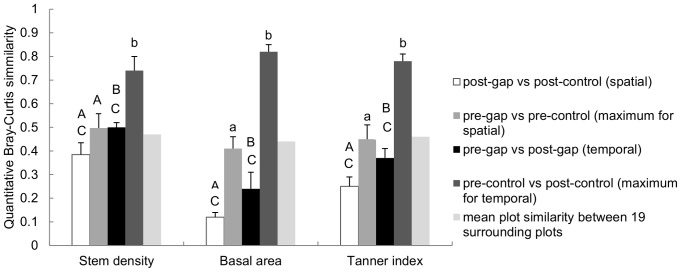
Quantitative Bray-Curtis similarity indices for stem density, basal area and recovery (mean of stem density and basal area) showing the recovery of four gap plots compared with their controls (plot pairs 1–4) and with their pre-gap composition.For comparison, the mean similarity index amongst 19 plots in the surrounding forest in 2009 is also shown. Maximum similarity for the spatial comparison was taken as the mean similarity between pre-gap and pre-control plots and, for the temporal comparison, as the mean similarity between the pre-control and post-control plots. The differences in mean quantitative Bray-Curtis similarity index within each of the three panels were computed using paired t-tests between bars labelled with the same letter; where the letter is shown as lower case it indicates a significant difference from where it is upper case, where both are shown as upper case the difference was not significant.